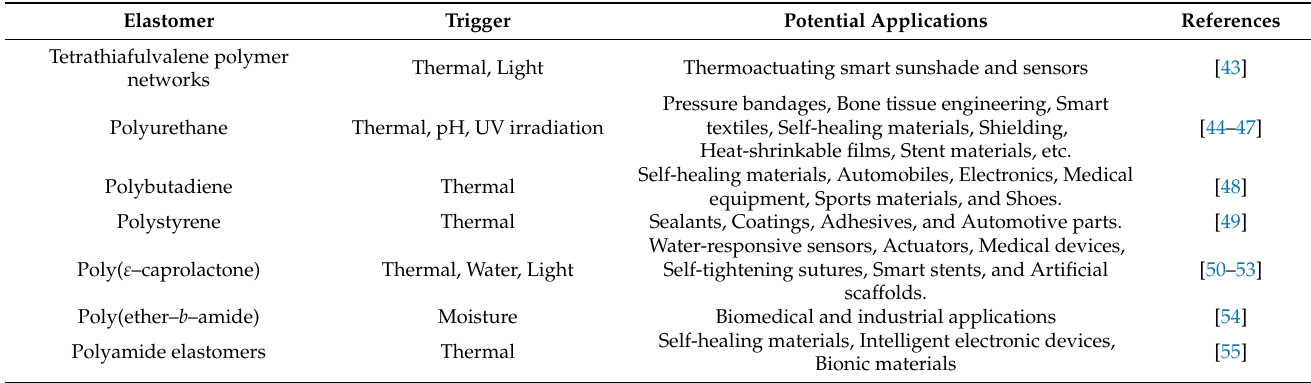
Figure 2. The shape memory process of tetrathiafulvalene elastomer networks (TTF SME) and their applications; ( a ) photograph and thermographic images of TTF SME, ( b ) the sunshade thermo- responsive, and ( c ) high-temperature warning sensor [43]. Adapted with permission from [43]. Copyright 2022 American Chemical Society. Table 2. Example SMEs and their potential applications.